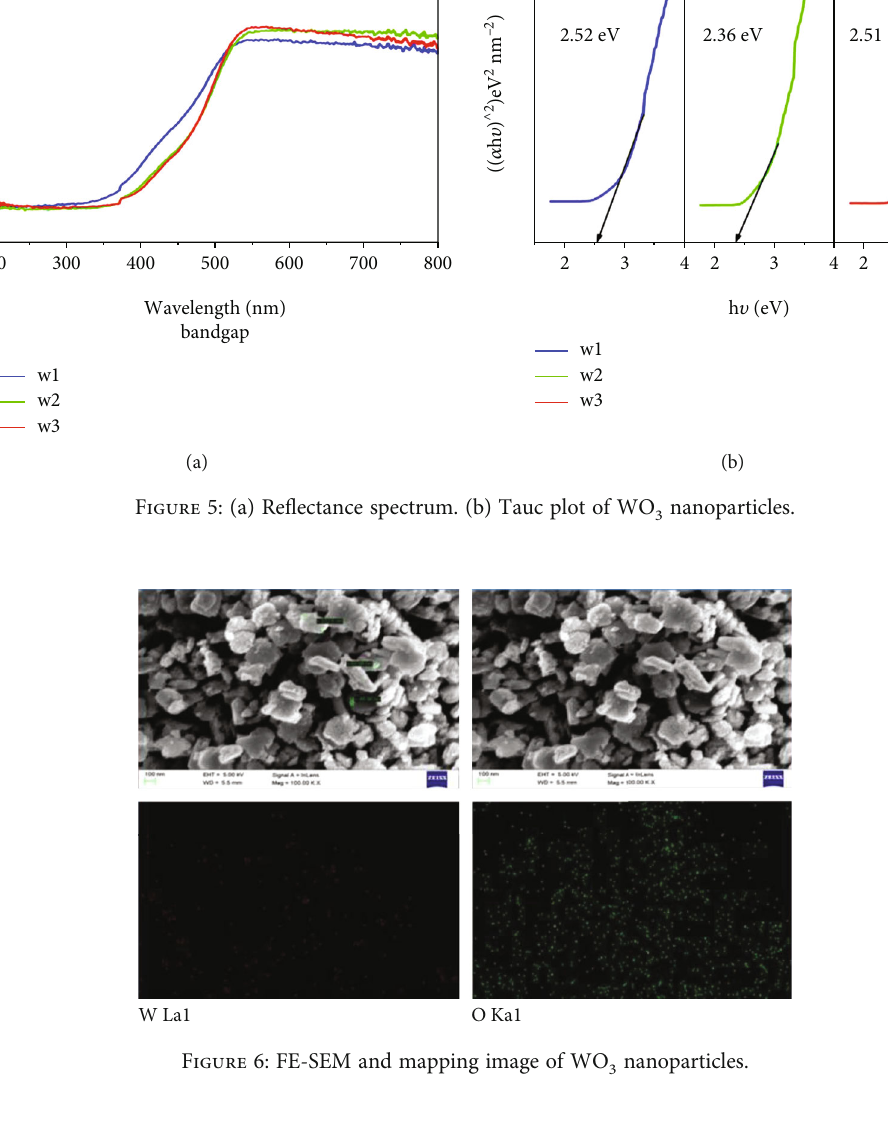
nanoparticles. 3